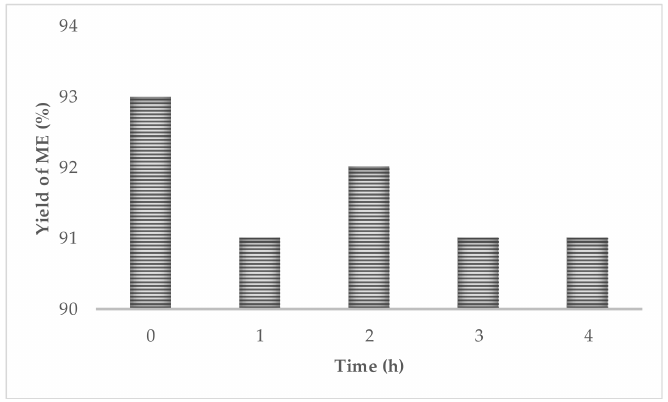
Figure 7. Stability of the solid acid catalyst.